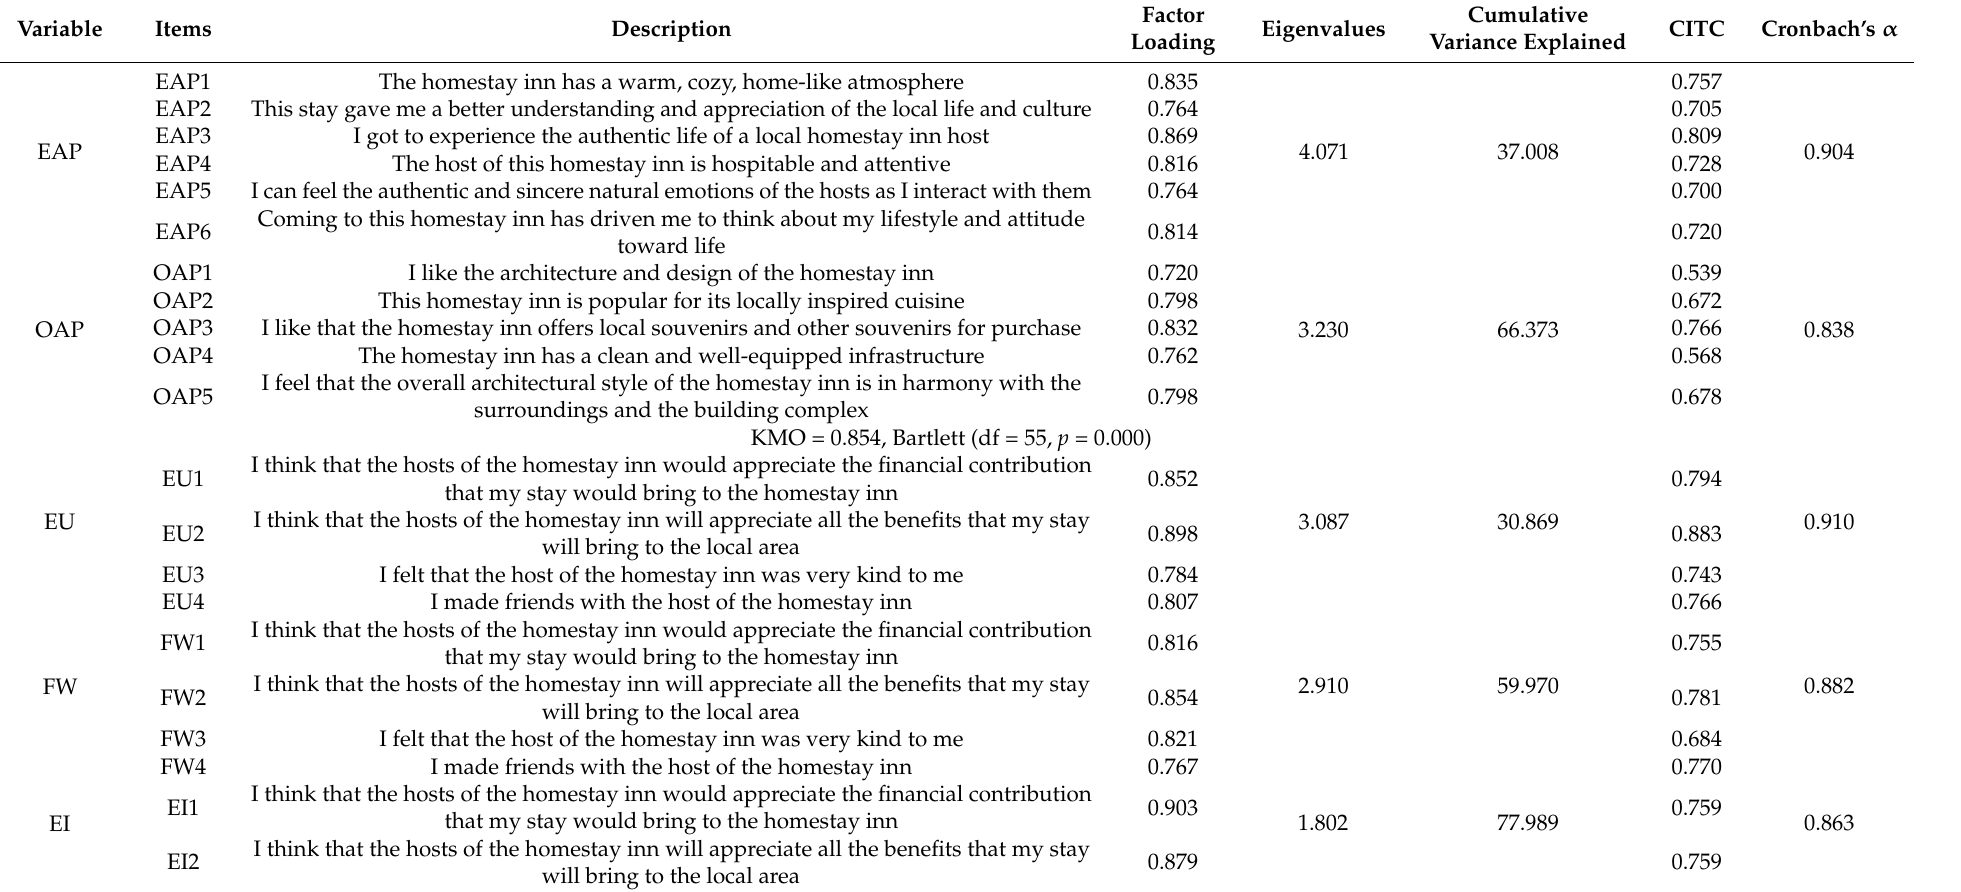
Table 1. Exploratory factor